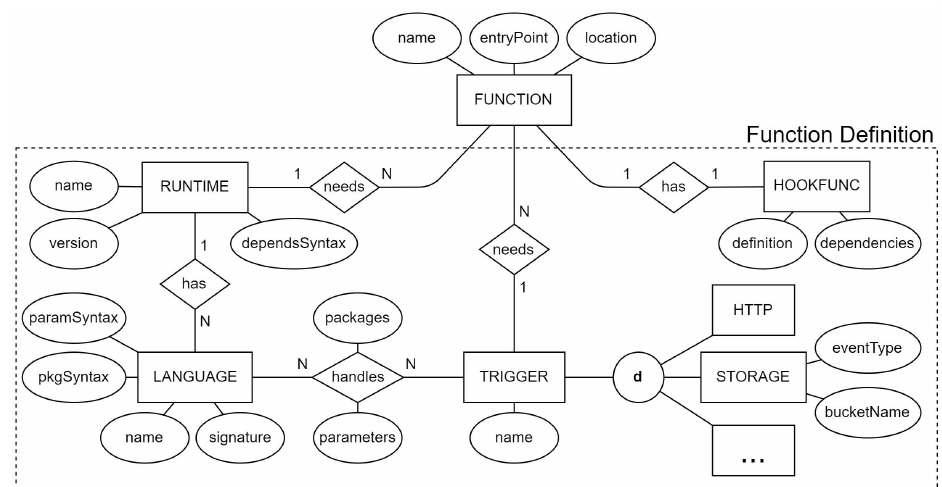
Figure 4. Function definition